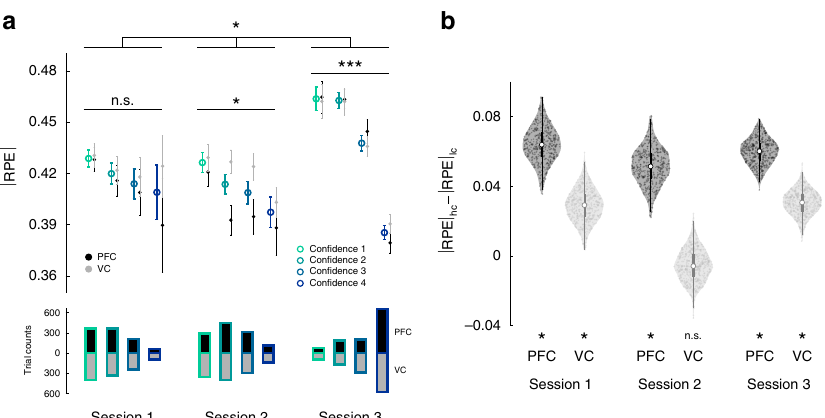
Fig. 5 Computational modelling of behaviour: metacognition correlates with RL sd . Using the noiseless state-dependent RL algorithm we computed the magnitude of reward-prediction error |RPE|, which re fl ects the uncertainty in learning the gambling task. |RPE| and con fi dence ratings were taken from within the same trial. In temporal order this means that con fi dence was fi rst, and |RPE| followed, as it was computed at outcome time (end of the trial). a |RPE| was signi fi cantly modulated by con fi dence from session 2: Higher perceptual con fi dence was associated with smaller |RPE|, meaning that a high con fi dence choice had lower probability to result in an unexpected reward. Coloured circles represent the median across all subjects pooled, light grey circles represent the median across subjects pooled from the VC group, and dark from the PFC group; error bars the SEM. The histograms at the base represent the trial counts for each con fi dence level, for both VC (lower) and PFC (upper) groups. Signi fi cance was assessed with linear mixed effects models (two-sided p values, uncorrected). *(interaction) P = 0.02, n.s. (session 1) P = 0.68, *(session 2) P = 0.012, ***(session 3) P = 1.56 × 10 − 12 . b Bootstrapped mean |RPE| difference between high and low con fi dence. Trials were fi rst split according to the within-session median con fi dence: below the median as ‘ low con fi dence ’ , equal or above the median as ‘ high con fi dence ’ . For each group, session, bootstrapping ( n = 500 runs) was applied as follows: in each run, high and low con fi dence trials were sampled with replacement, and the difference of the means was thus computed. For each distribution, the absence of 0 in the 95% CI was taken as signi fi cance (*) at P < 0.05 (session 1: PFC = [0.045 0.083], VC = [0.010 0.046]; session 2: PFC = [0.032 0.073], VC = [ − 0.022 0.012]; session 3: PFC = [0.046 0.073], VC = [0.016 0.044]). The shaded areas in the violin plots represent the population spread and variance, the white dot the median, the thicker line the interquartile range, coloured dots individual bootstrap samples. The experiment was conducted once ( n = 18 biologically independent samples); single-trial data were pooled across